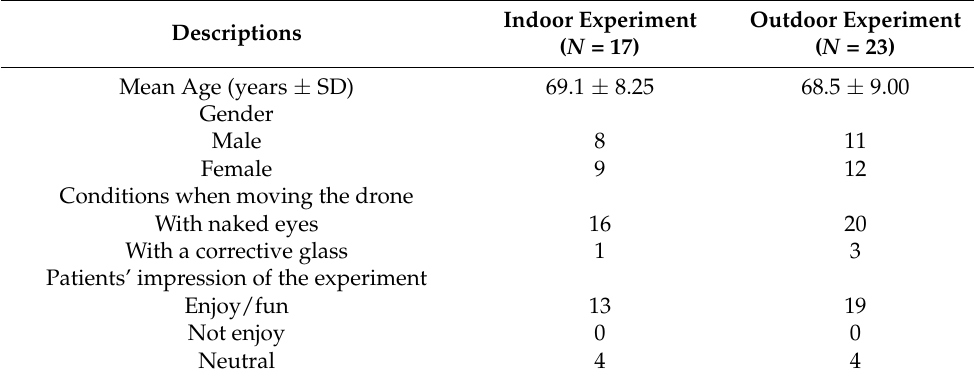
Table 1. The summary of the indoor and outdoor experiments of the